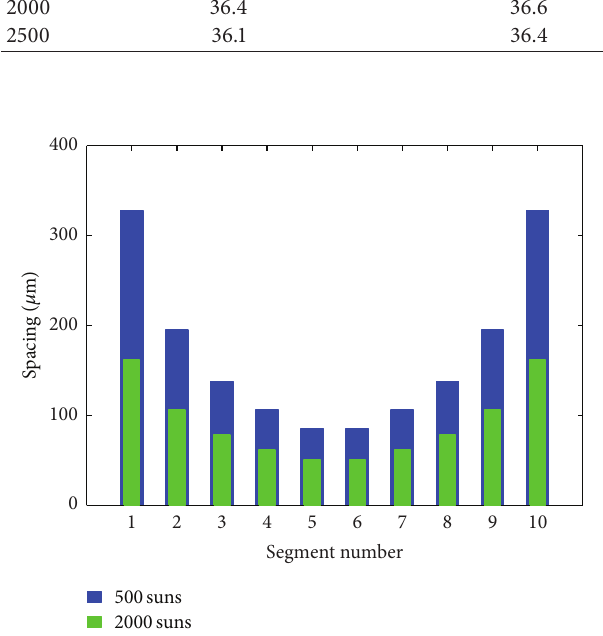
Figure 7: Optimal nonuniform spacing profile at (a) 500 suns and (b) 2000 suns under a Gaussian irradiance profile (PAR = 5.3) with the solar cell divided into ten equal